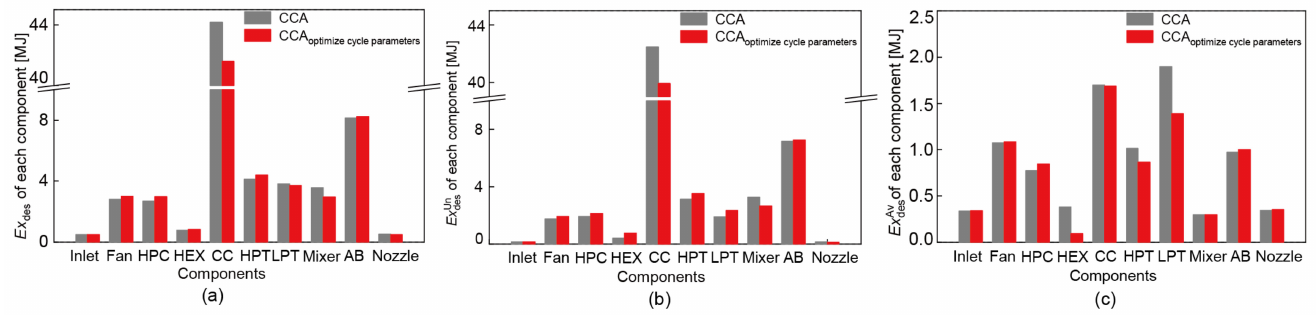
Figure 14. Comparison of exergy destruction in each component between different schemes. ( a ) Total exergy destruction in each component; ( b ) Unavoidable exergy destruction in each component; ( c ) Avoidable exergy destruction in each